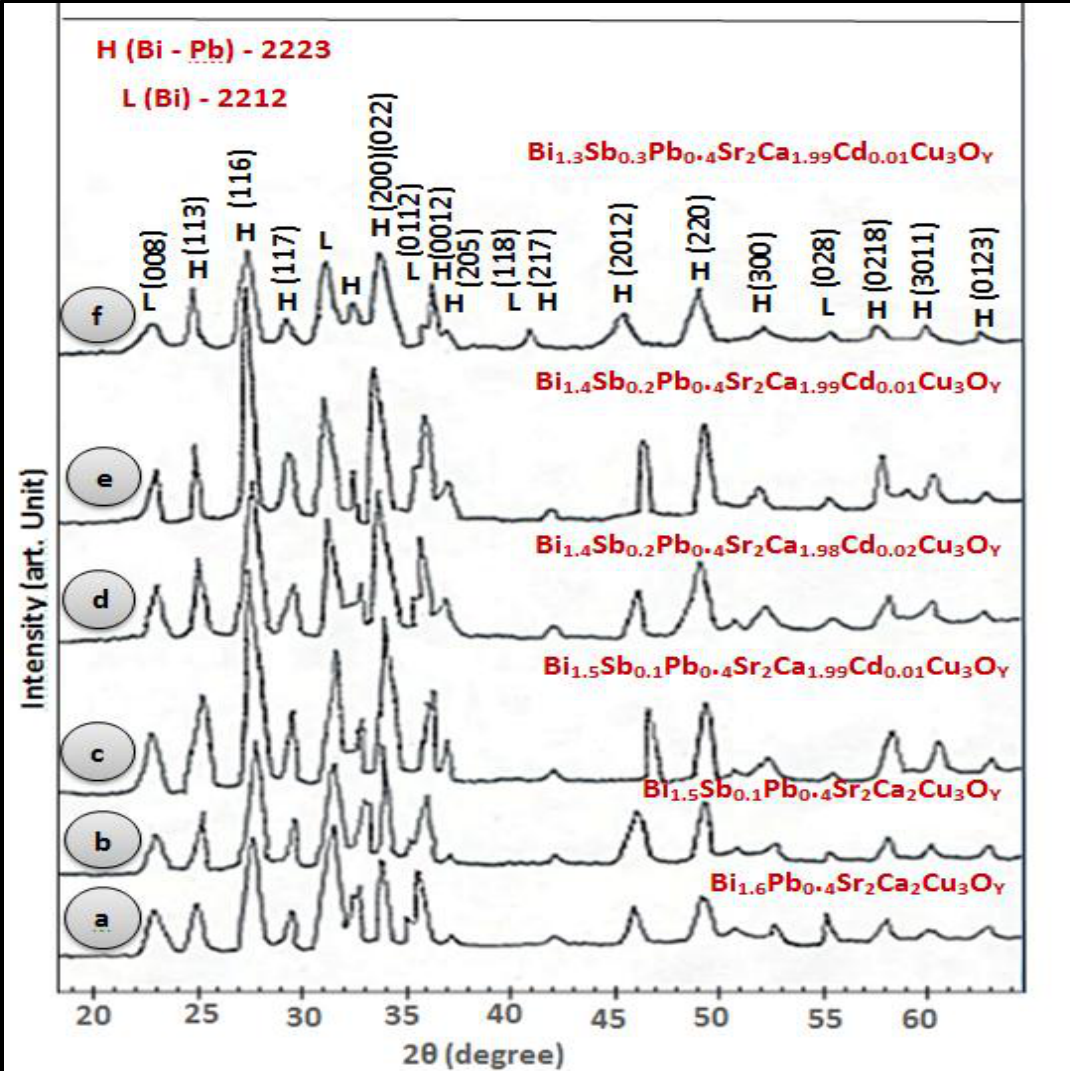
Fig. 2: X-Ray diffraction patterns of Bi of Cd and Sb content. Where (a): Un-doped sample, (b): for sample have (x = 0.1 and y= 0.00), (c): for samples have (x = 0.1 and y = 0.01), (d): for sample have (x = 0.1 and y= 0.02), (e): for samples have (x = 0.2 and y = 0.01) and (F): for sample have (x = 0.3 and y= 0.01). where the symbol (H) indicates to the (BiPb)-2223 (high-T (L) indicates to the (BiPb)-2212 (low-T